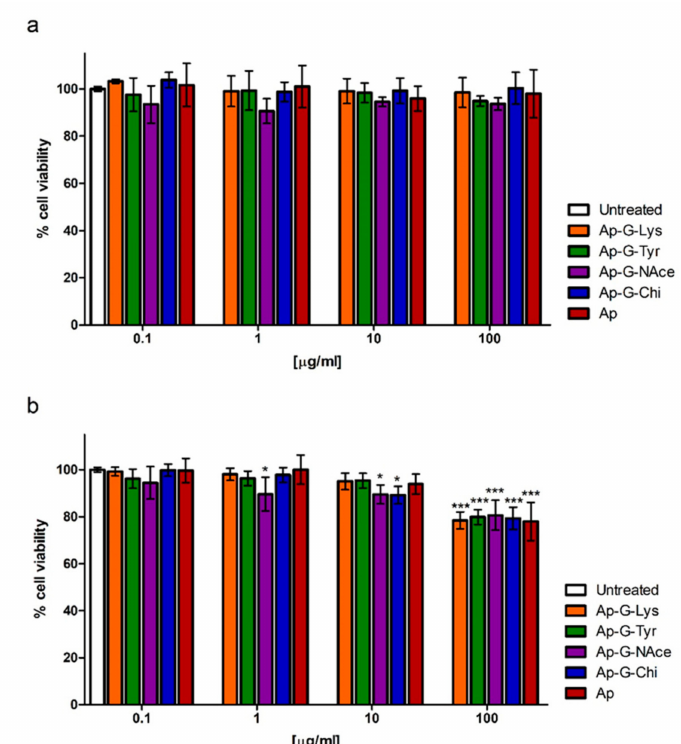
Figure 5. Viability of GTL-16 cells ( a ) and m17.ASC cells ( b ) incubated with graphene–apatite biohybrid composites (Ap-G) for 72 hours in 3-(4,5-Dimethylthiazol-2-yl)-2,5-diphenyltetrazolium bromide (MTT) essays. The graphene flakes were prepared by the liquid-phase exfoliation method in presence of Lys, Try, NAce, and Chi. Data represent means ± SD of four independent experiments performed in triplicate, and statistical analyses were carried on using one-way ANOVA, with a Bonferroni comparison test. For statistical analysis, all data were compared to untreated